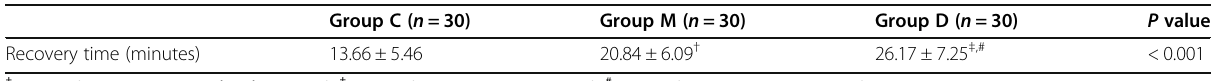
Table 6 Anesthesia recovery time expressed as mean ± SD